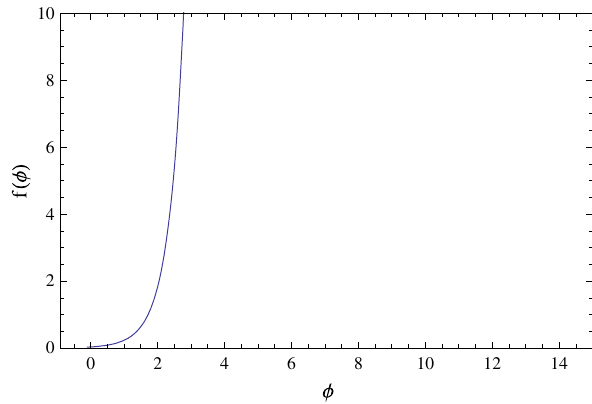
Fig. 13 Variation of φ( z ) with the variation of z (Model II) by con- sidering the best fit values w 0 = − 0 . 797 ,w 1 = 0 . 499